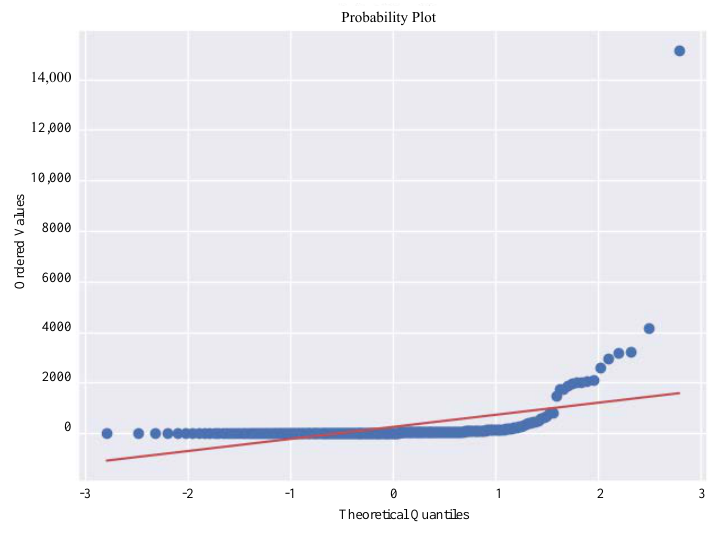
Figure 3. Original diagnosis numbers Q-Q